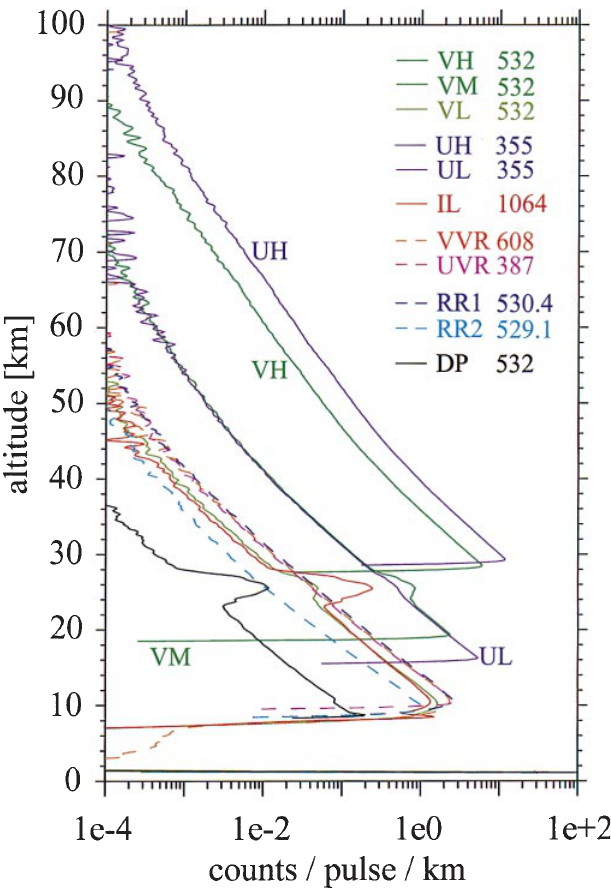
Fig. 8. Performance of the multichannel detector system, including the altitude profiles for 11 detector channels using 7 di(cid:128)erent wavelengths (for details, see text). The simultaneously collected profiles from the 24 DWTS detectors are not shown. The counts were integrated during the night of January 7/8, 1997 over the period from 20:01 UT until 05:19 UT. Photons backscattered from altitudes below 8 km are blocked by the mechanical chopper from reaching the detectors. In addition, for a number of the detector channels, electronic shuttering of the multipliers prevent high currents in the photomultiplier chain of dynodes. Between 23 and 28 km altitude, a polar stratospheric cloud produces Mie scatter in the (from left to right ) DP , VL , IL , UL , and VM channels. At the same altitudes, the vibrational ( VVR , UVR ) and rotational ( RR1 , RR2 ) Raman channels show no Mie backscattered signal. The cloud signature in the DP channel indicates that the scattering cloud particles are of non-spherical